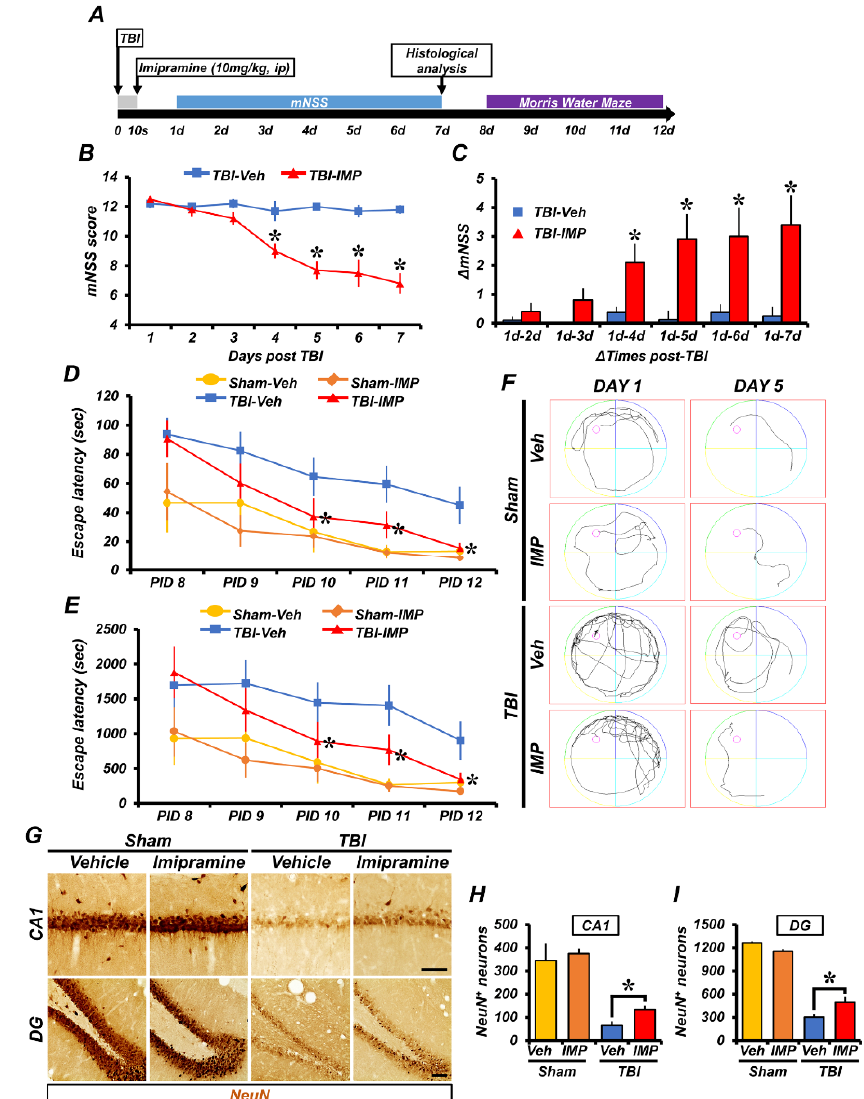
Figure 5. Imipramine restored TBI-induced delayed neuronal loss, neurological deficits, and memory dysfunction. ( A ) Experimental procedures are demonstrated by timeline. We performed the mNSS test every day for 7 days and then histological analysis. We performed the Morris water maze (MWM) test for five consecutive days from day 8 to 12 after TBI. ( B ) mNSS determined in TBI-operated groups on days 1–7 after TBI. Score of up to 18 means that all tasks failed; score of 0 means that all tasks succeeded. ( C ) delta-mNSS determined in TBI-operated groups. Data are mean ± SEM; n = 4 from each sham group; n = 6 from each TBI group. ( D ) We performed the Morris water maze (MWM) test on days 8–12 after TBI. We recorded the platform arrival time for 5 consecutive days. ( E ) Distance taken to arrive at platform for same schedule on 5 consecutive days of MWM. ( F ) MWM tracking record of sham-operated and TBI-operated groups at start and termination of MWM. Data are mean ± SEM; n = 5 from each sham group; n = 10 from each TBI group. ( G ) Representative images showing live neurons detected by NeuN in hippocampal CA1 and DG regions 1 week after TBI in sham-operated groups. Scale bar = 100 µm. ( H , I ) Quantification of number of live neurons in hippocampal CA1 and DG 1 week after TBI. Data are mean ± SEM; n = 4 from each sham group; n = 6 from each TBI group. * p < 0.05 vs. vehicle-treated TBI group.